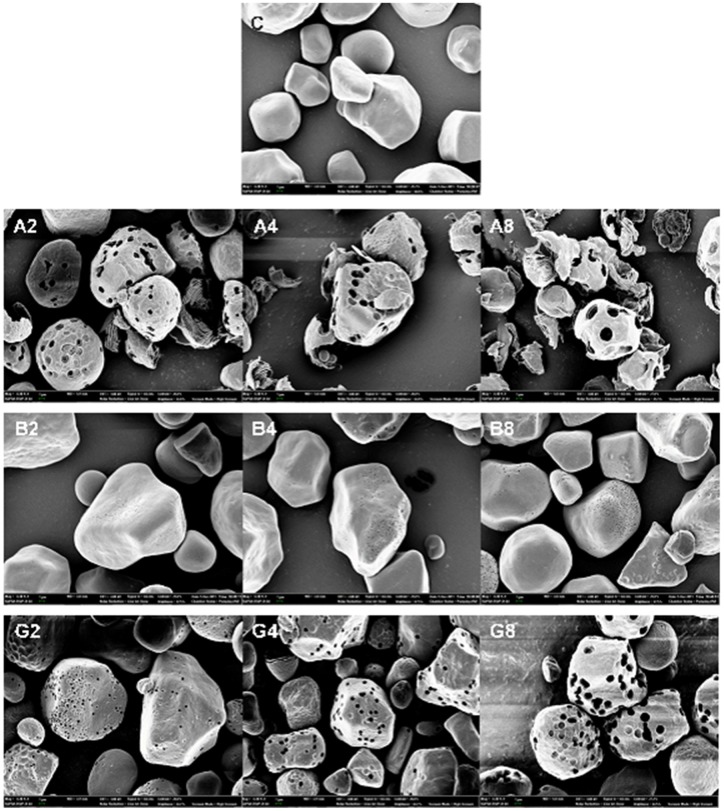
FE-SEM images of porous starch granules produced by enzymatic hydrolysis at 40°C.C, control (NCS); A, α-amylase; B, β-amylase; G, glucoamylase. The numbers in the image panels mean the reaction time in hour scale. For example, A2 means that native starch granule was treated with α-amylase for 2 h. The magnification is 6,500 ×.